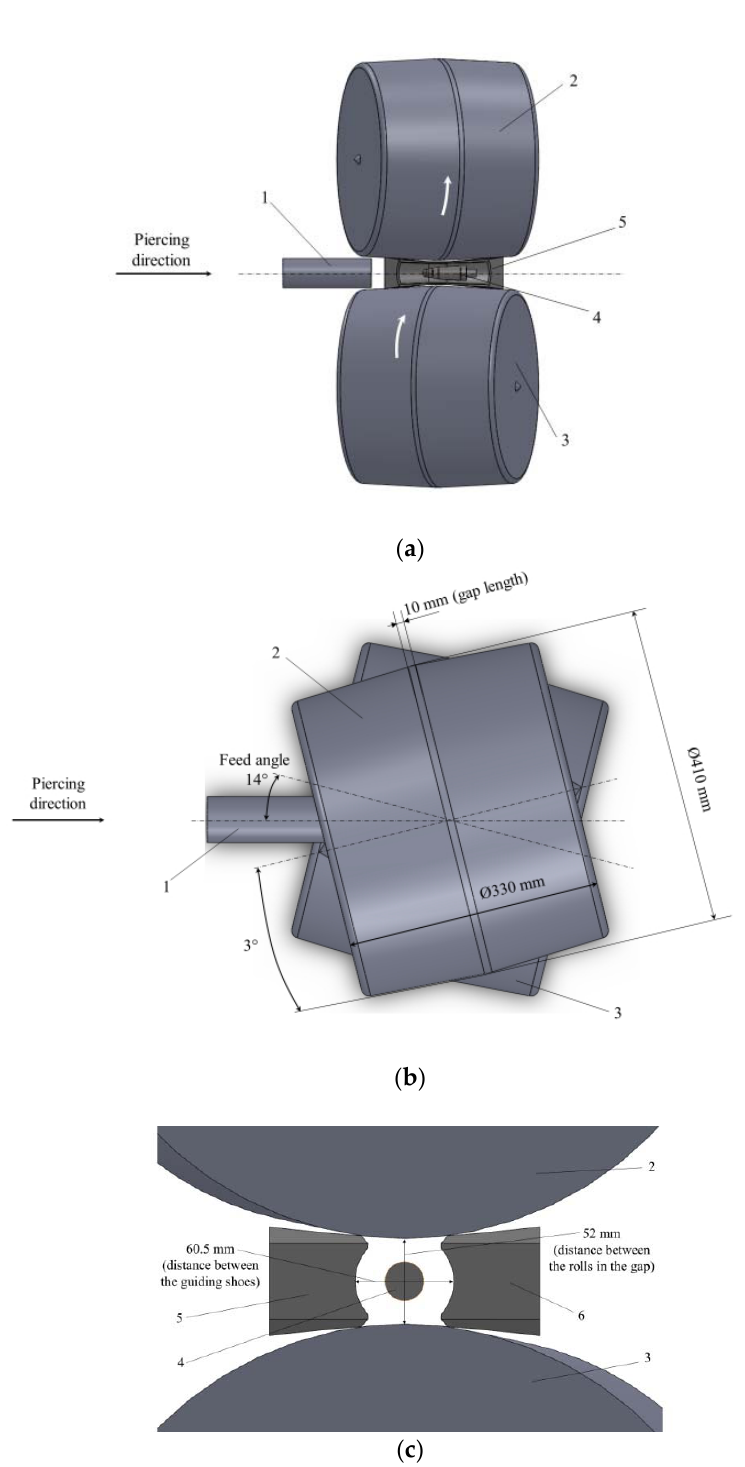
Figure 1. Screw piercing scheme in the MISIS ‐ 130D two ‐ high mill: ( a ) side view, ( b ) top view, ( c ) gap cross ‐ section; 1—billet, 2, 3—rolls, 4—plug, 5, 6—guiding shoes.